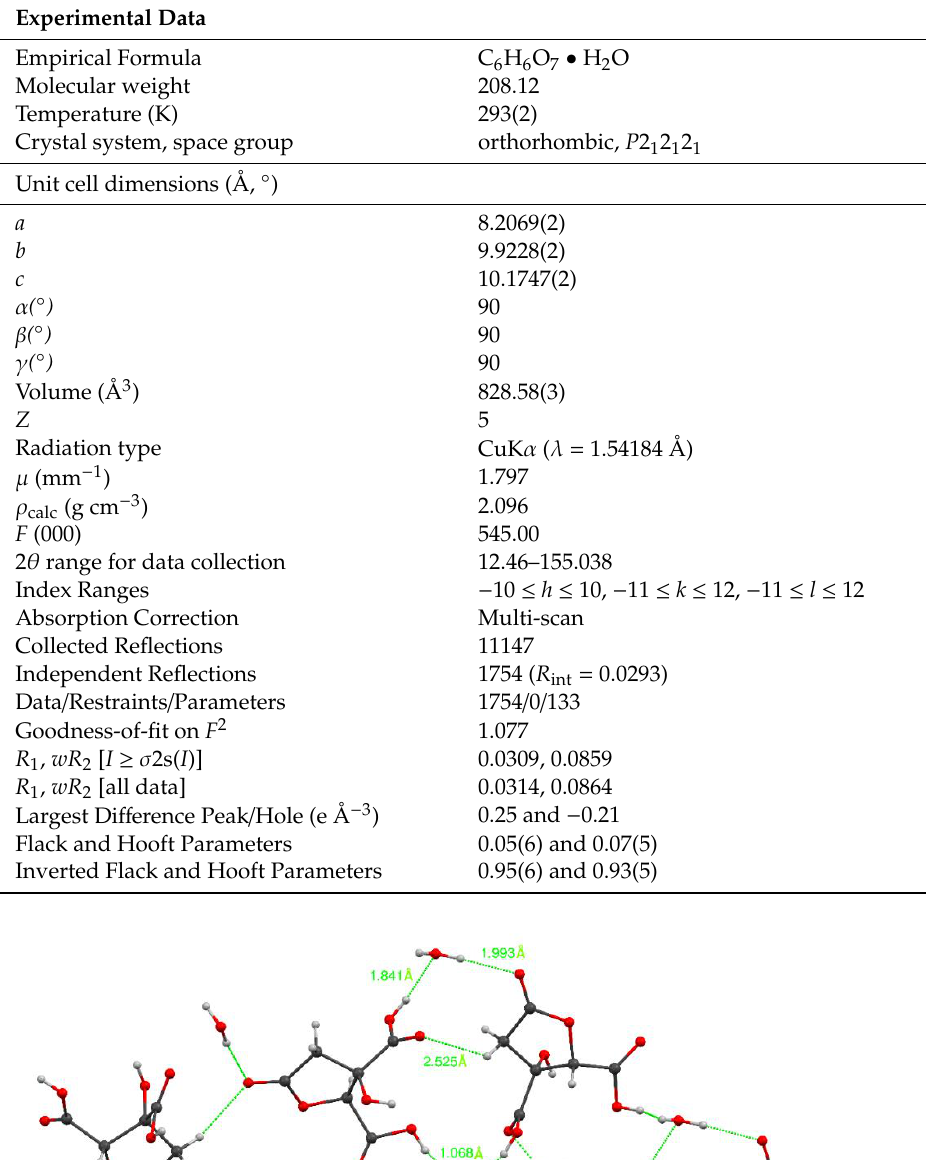
Table 4. X-ray spectroscopy details of crystal data and structure refinement parameters of hibiscus acid isolated from Hibiscus sabdari ff a calyx acetonic extract.